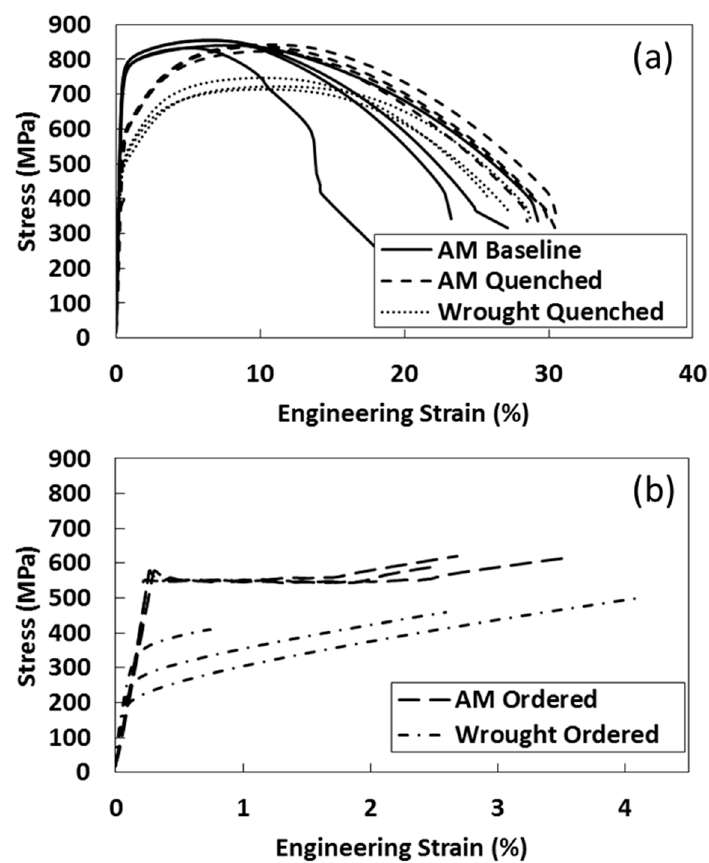
Figure 4. Representative stress–strain curves for high ductility conditions ( a ) and low ductility conditions ( b ).